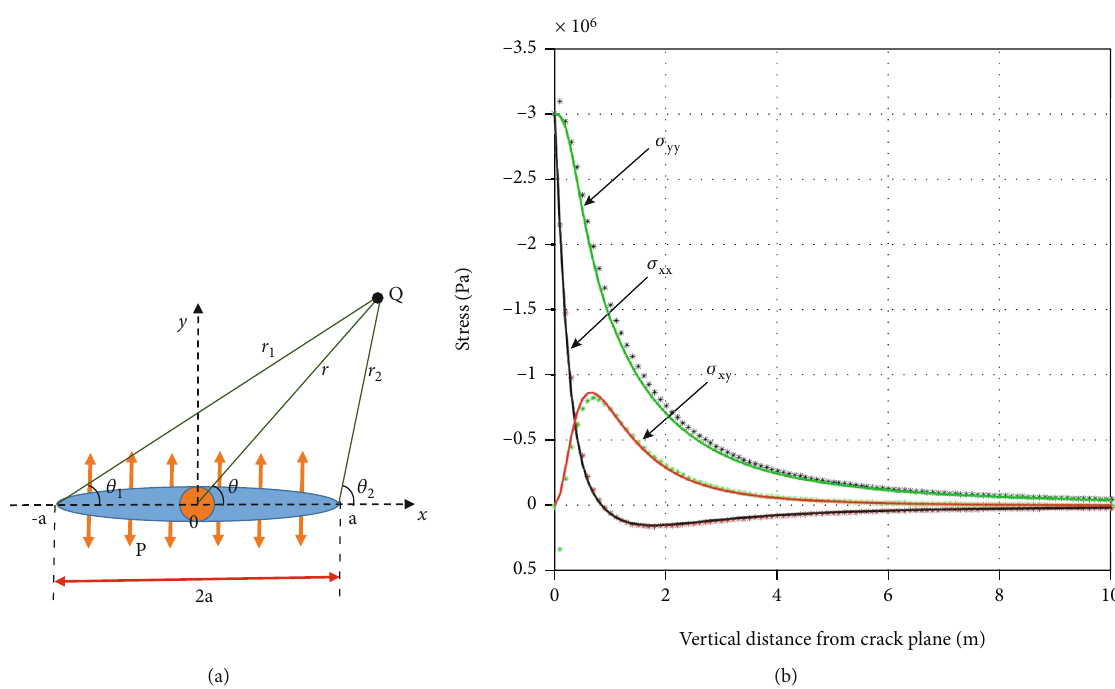
Figure 2: Computer program fl ow chart: (a) mechanical model; (b) comparison of simulation results; “ ∗ ” represents the numerical solution. Solid lines represent analytical